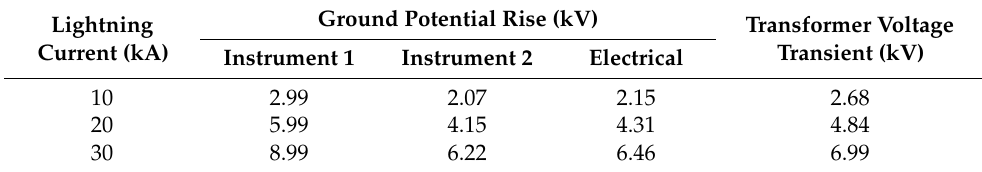
Table 4. Potential rise due to GPR on the system of separated grounding rods.